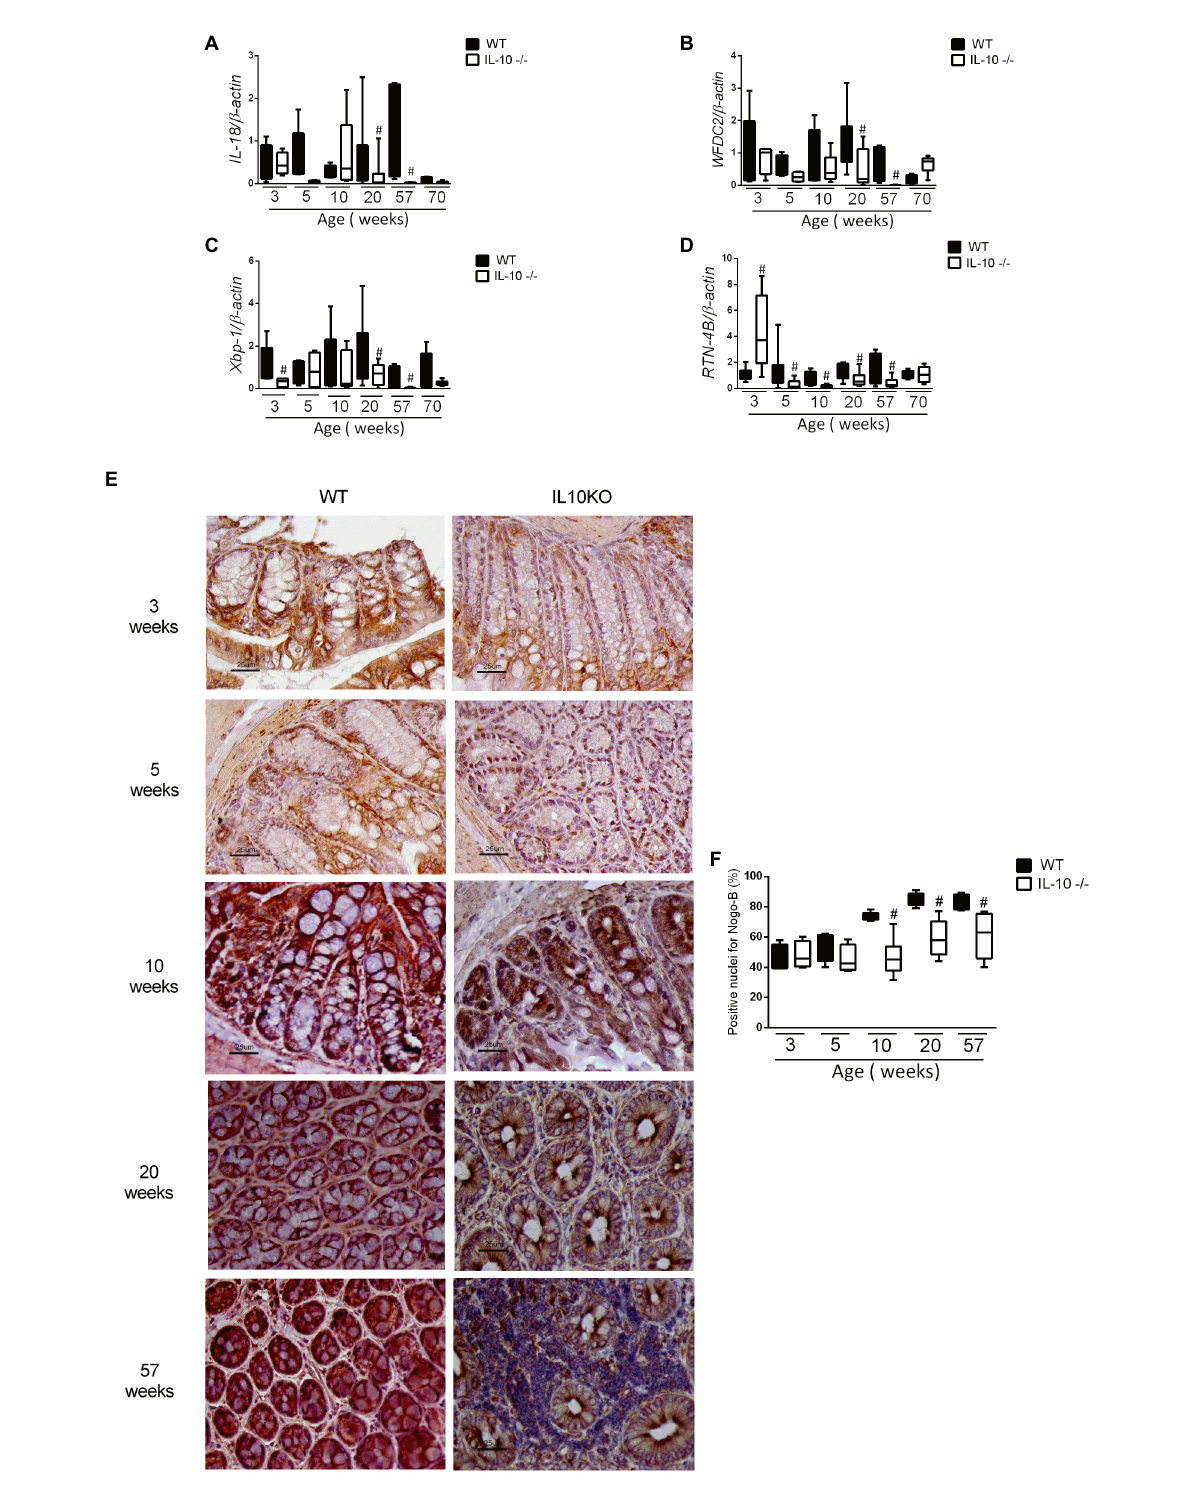
FIGURE 5 Analysis of gene expression by qPCR of IL-18 (A) , WFDC2 (B) , Xbp1 (C) , and RTN-4B/NogoB (D) in the colon of WT and KO mice in all evaluated ages. C57Bl/6 wild type (WT) group was represented in black and IL-10 deficient mice (IL-10 − / − ) group in white. #p < 0.05 with respect to WT of the same age. (E) Histological sections of the colon of WT and IL-10 − / − mice at 3, 5, 10, 20, and 57 weeks of age labeled with RTN-4B antibody and revealed with DAB ( n = 6 for each strain and age). (F) RTN-4B positive nuclei count from images acquired in ACT-1 software in blindly and independent